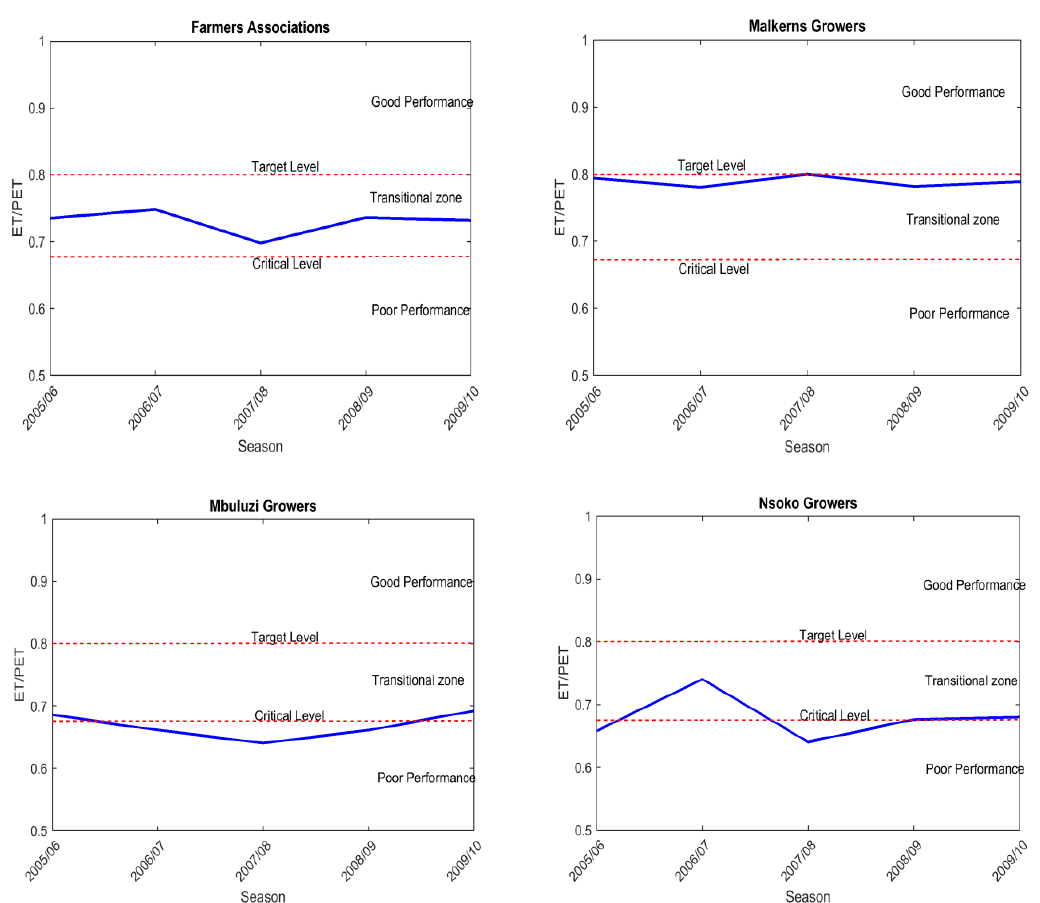
Figure 6. Temporal variation of relative ET of selected grower clusters